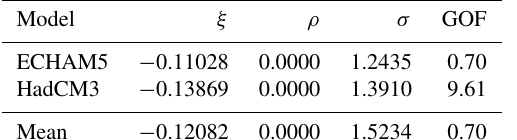
Table 3. Greenland SMB sea level component calibration results Table 5. Antarctic SMB sea level component calibration results with optimal parameter sets for the available CMIP5 models. Cal- with optimal parameter sets for the CMIP3 models ECHAM5 and ibration parameters are introduced in Sect. 2.6. GOF is given as HadCM3. Calibration parameters are introduced in Sect. 2.6. GOF weighted RSS divided by the number of calibrated model years is given as weighted RSS divided by the number of calibrated model (weight Greenland SMB SLE contribution [mm]: 1). The optimal years (weight Antarctic SMB SLE contribution [mm]: 1). The opti- set for the mean response of the calibration data is given at the bot- mal set for the mean response of the calibration data is given at the tom of the table. bottom of the ϕ GOF